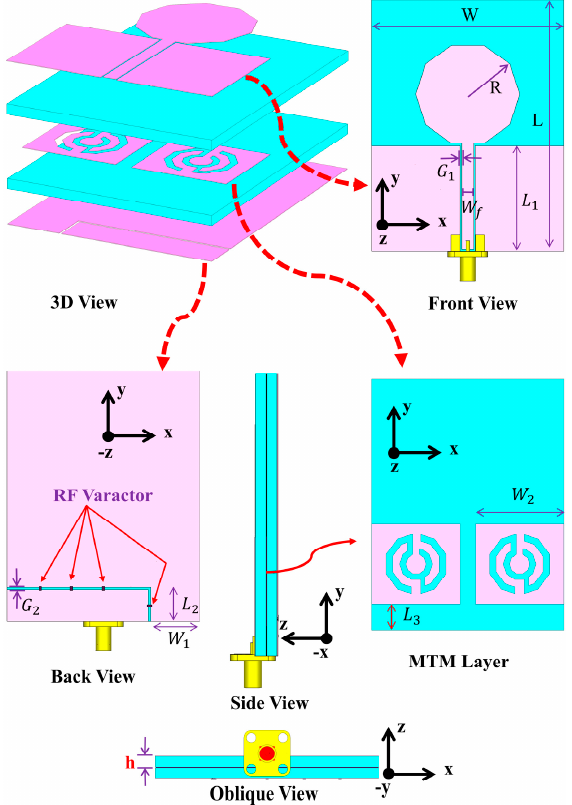
Figure 3. Schematic diagram of the MBRU antenna including the MTM layer. Table 3. Parameter dimensions of the MBRU antenna.